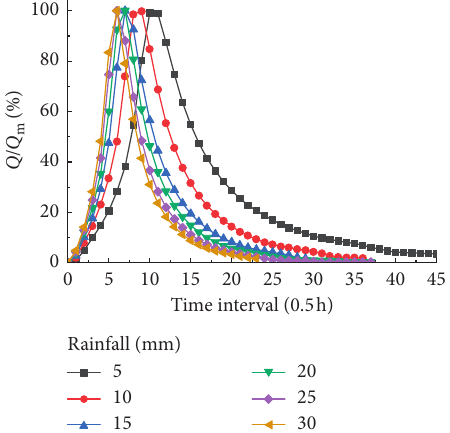
Figure 2: Hydrographs of different rainfall values.